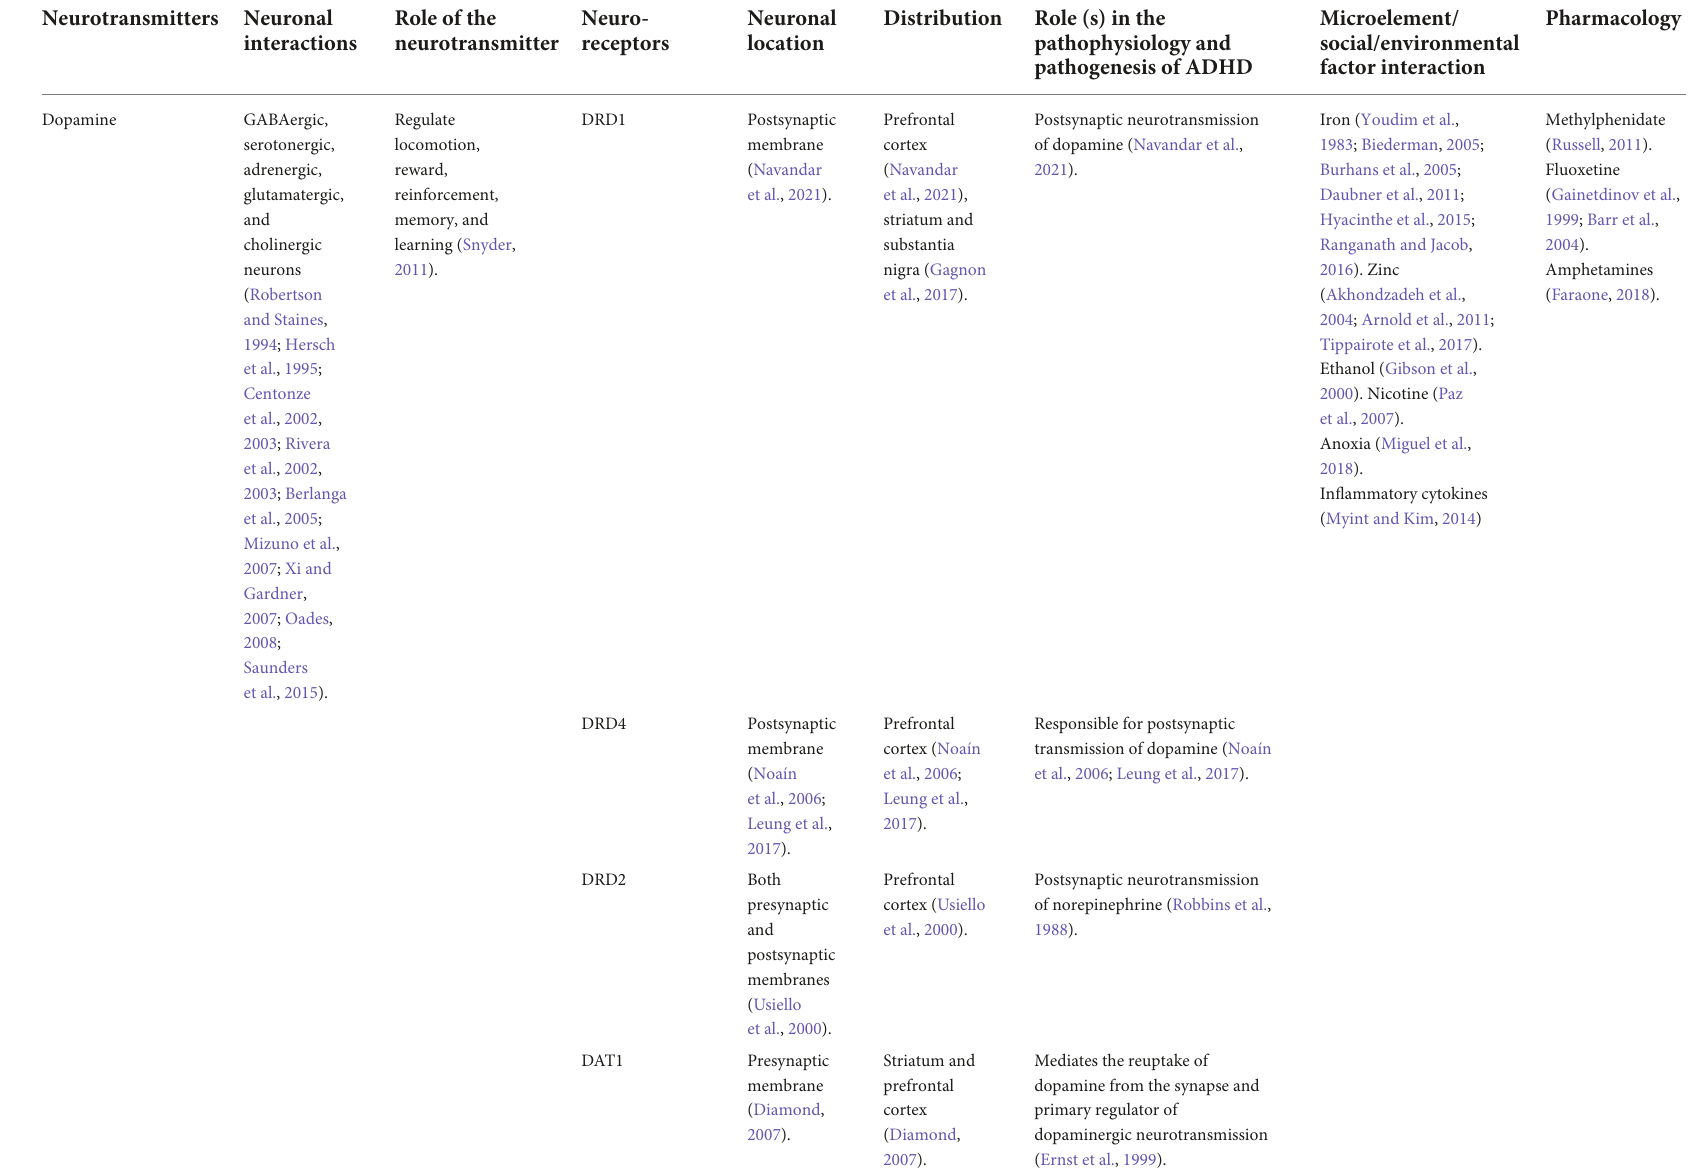
TABLE 1 A summary of different neurotransmitters and neuroreceptors and the roles they play in the pathophysiology and pathogenesis of